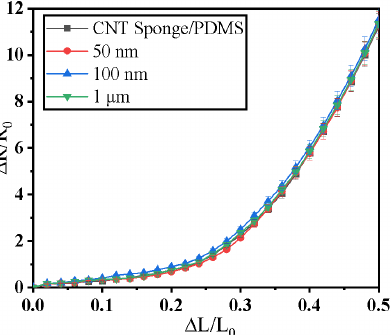
Figure 4. CNT sponge/PDMS/WO 3 structure force ‐ sensitive characteristic curves with different WO 3 particle sizes.